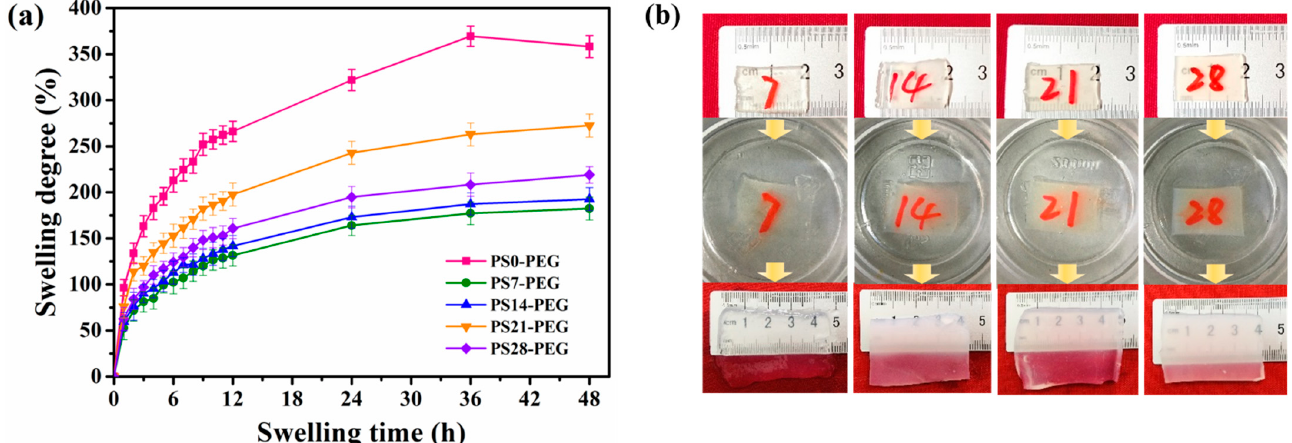
Figure 5. Swelling behavior of hydrogels in seawater: ( a ) Swelling degree vs. swelling time; ( b ) Specimen photos in the experimental procedure.